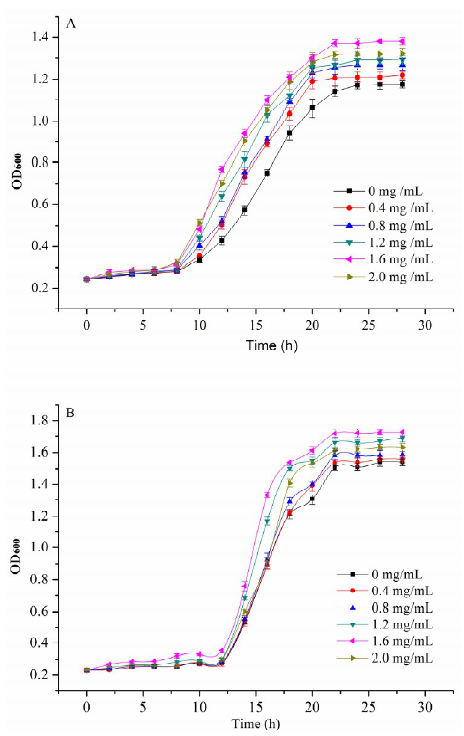
Figure 2. Effect of the addition of GE on the growth of Lactobacillus bulgaricus ( A ) and Bifidobacterium adolescentis ( B ).